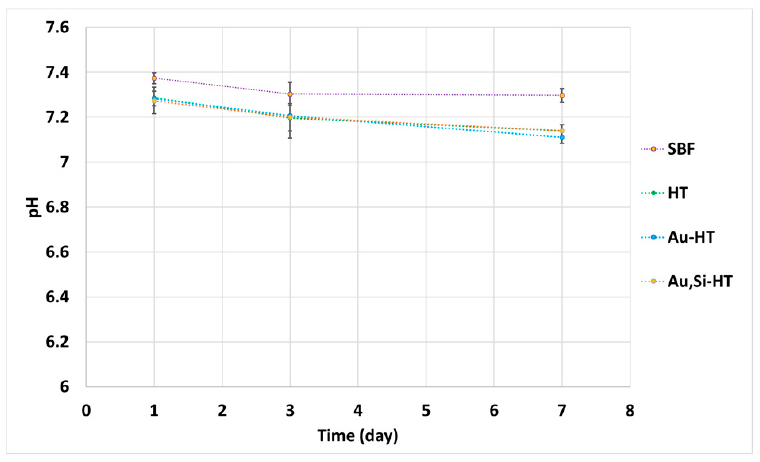
Figure 5. pH versus biomicroconcretes’ incubation time in simulated body fluid.